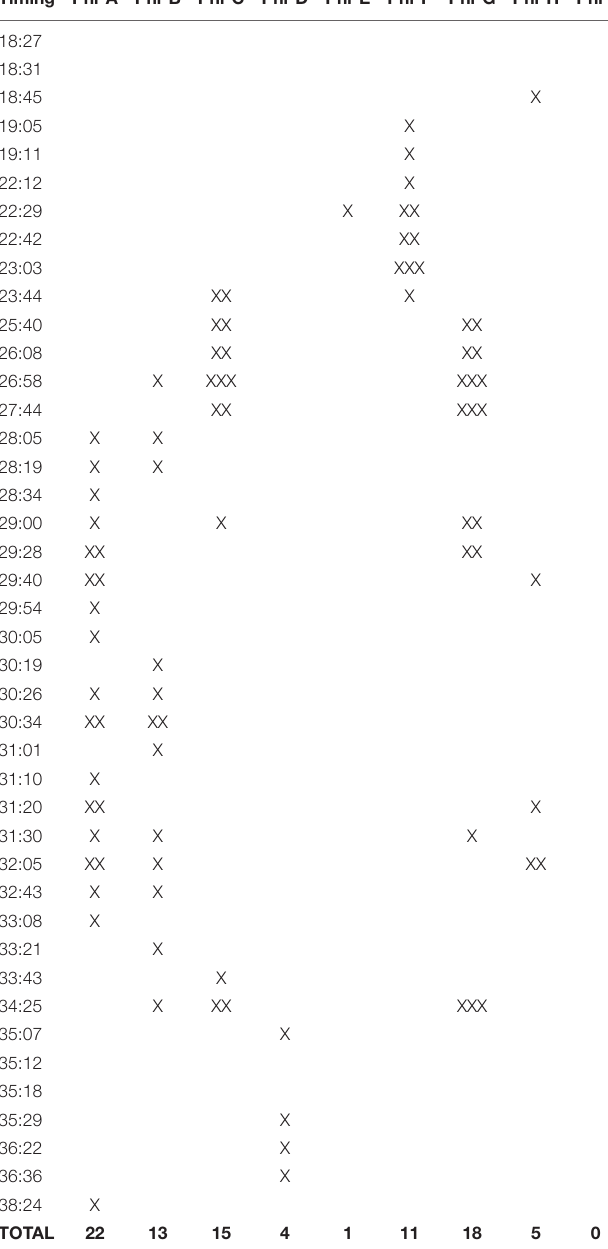
TABLE 3 | A tally of adult and immature phrases deployed as combinatorial components in group songs in Supplementary Audio 1 during the 20 min from 18:27 to 38:26 (each X = one delivery; some phrases feature more than once in the same group song).